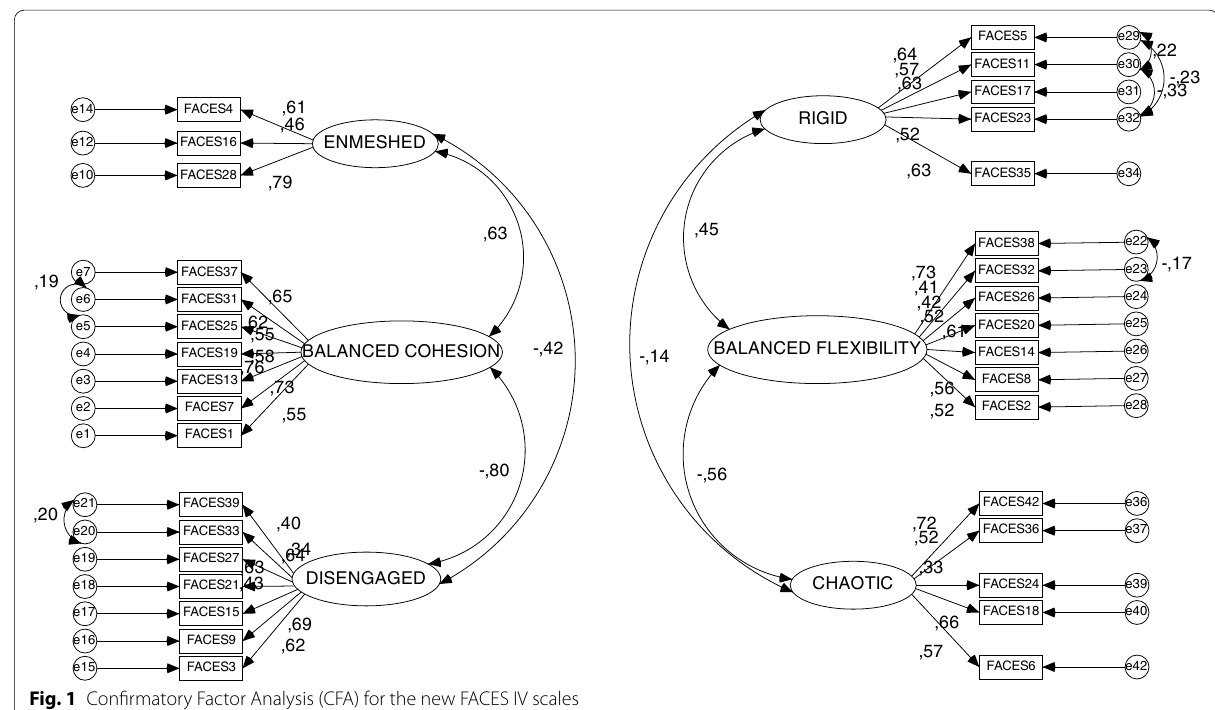
Fig. 1 Confirmatory Factor Analysis (CFA) for the new FACES IV scales